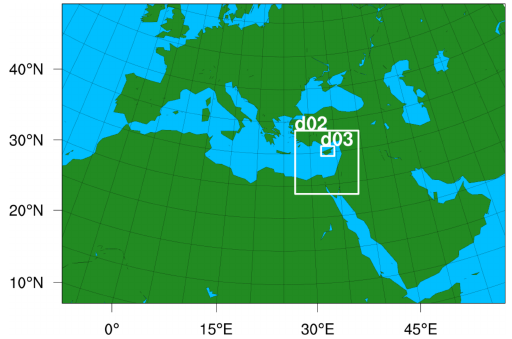
Figure 1. Model simulation